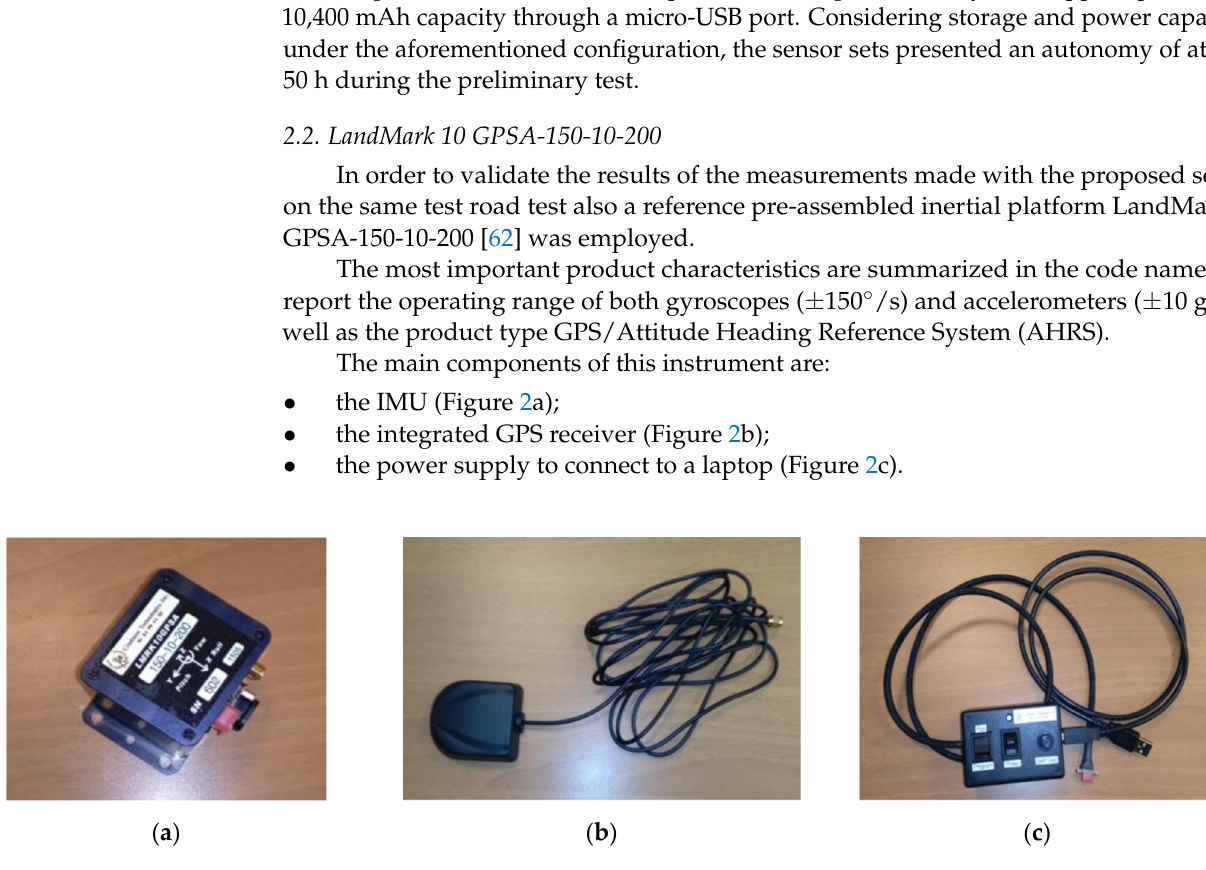
Figure 2. LandMark 10 GPSA-150-10-200 main component parts: ( a ) IMU; ( b ) the integrated GPS receiver; ( c ) the power supply.